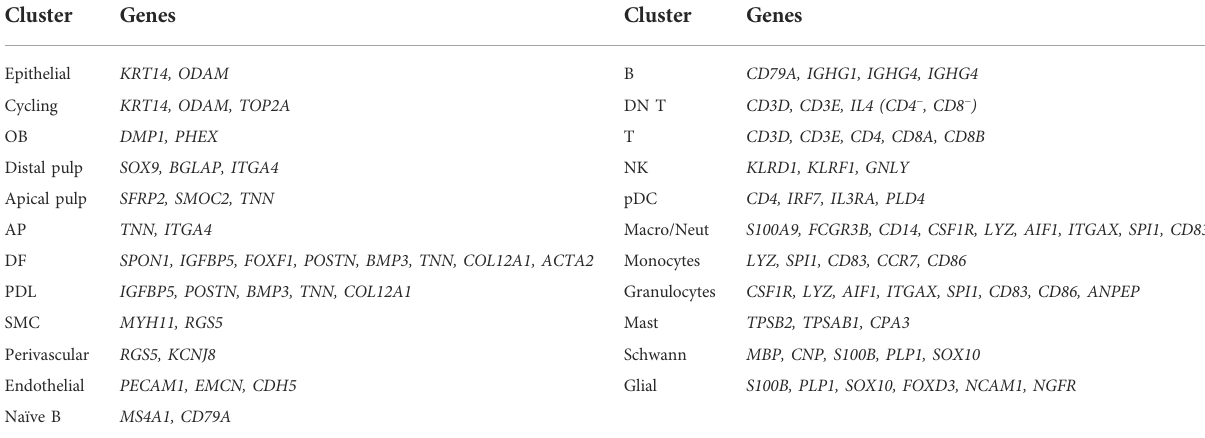
TABLE 6 Gene panels used for cluster annotation of human tooth cell